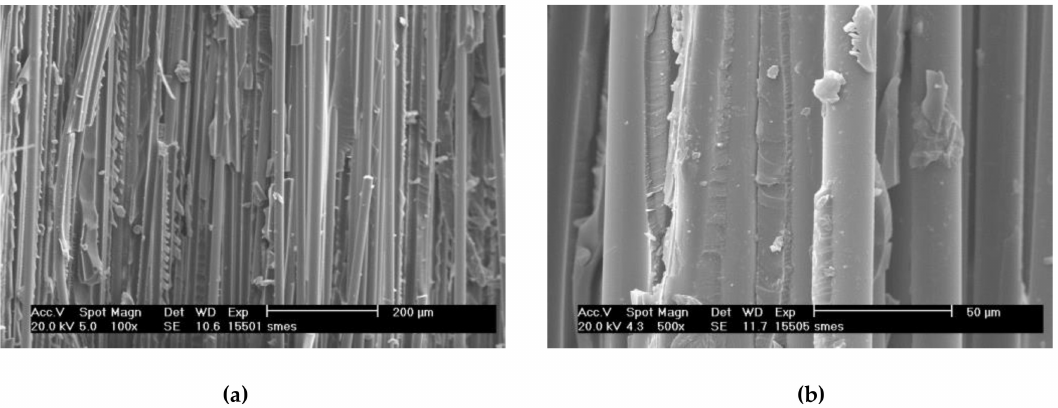
Figure 16. ( a ) SEM micrograph of fractured composite beam for stronger interfacial adhesion between the GFs and the polyester resin; ( b ) detailed